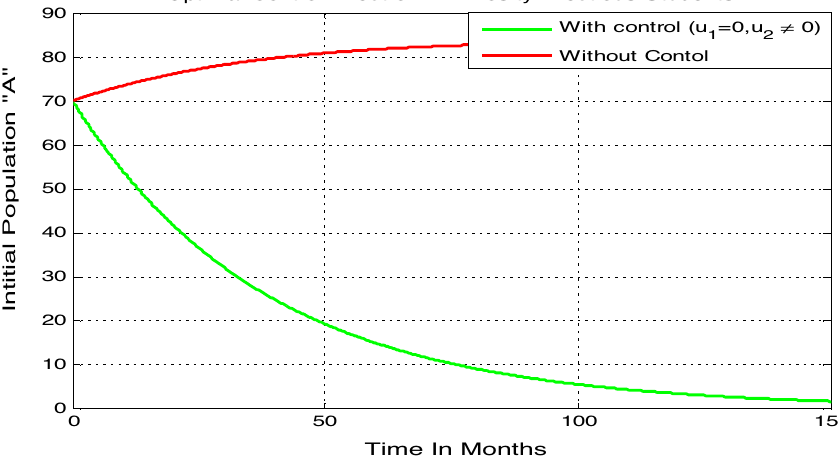
Figure 8. Variation in animosity infected students with treatment ( u 1 = 0 , u 2 = 0 ) control